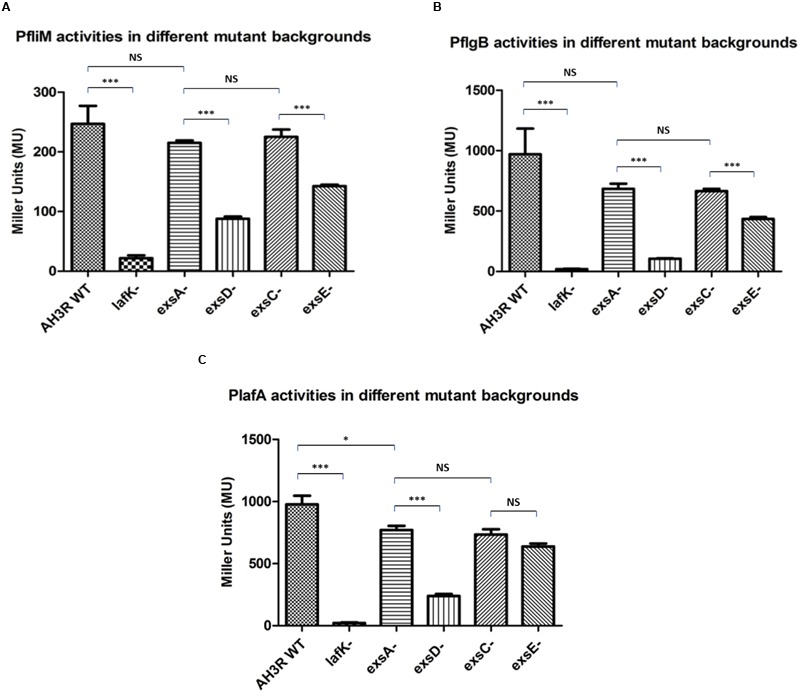
β-galactosidase activities of the aeromonad lateral flagella promoters PfliM, PflgB and PlafA in A. hydrophila AH3R wild type and mutant backgrounds. (A) Promoter activities of PfliM were significantly decreased in the lafK mutant, exsD mutant and exsE mutant when compared to the AH3R wild type, exsA mutant and exsC mutant. (B) Promoter activities of PflgB were significantly decreased in the lafK mutant, exsD mutant and exsE mutant when compared to the AH3R wild type, exsA mutant and exsC mutant. (C) Promoter activities of PlafA were significantly decreased in the lafK mutant and exsD mutant when compared to the AH3R wild type, exsA mutant and exsC mutant. While in the exsE mutant, promoter activity of PlafA was significantly lower than in the exsA mutant but at a similar level with the exsC mutant. The promoter activities were measured when each strain was grown on swarming agar at 30°C overnight. Assays were carried out in triplicate and the values are the means. The error bars showed Standard Error of the Mean (SEM). The significance was determined using Student’s t-test (∗p < 0.05, ∗∗∗p < 0.001).